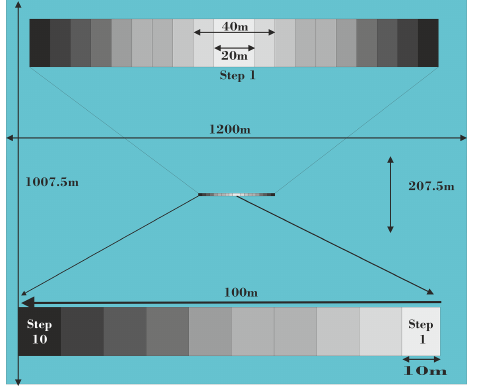
Figure 4. Simulated cavity widths. Table 1. Mechanical Property of Host Rock.